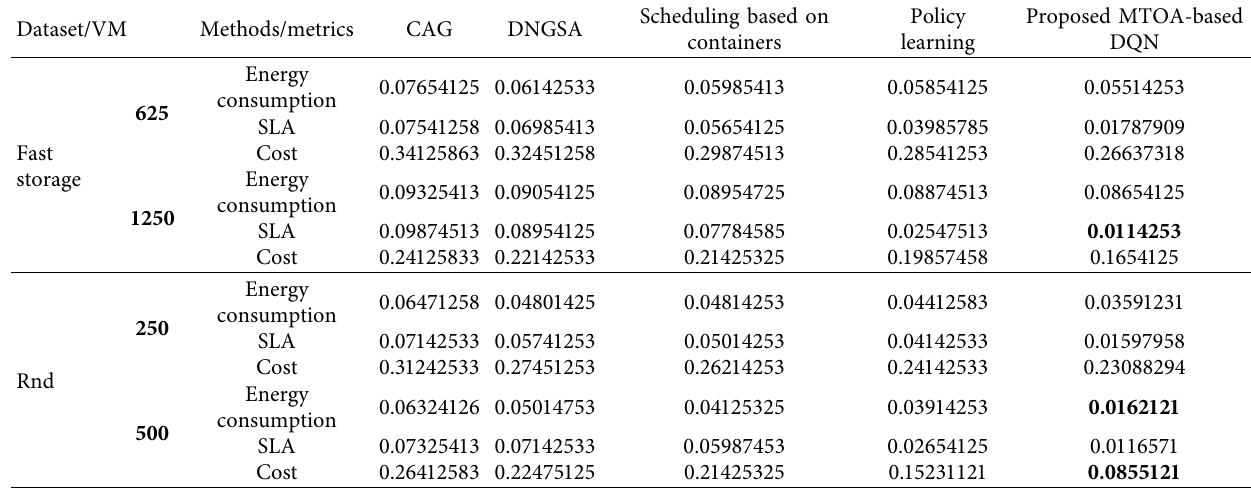
Table 4: Comparative